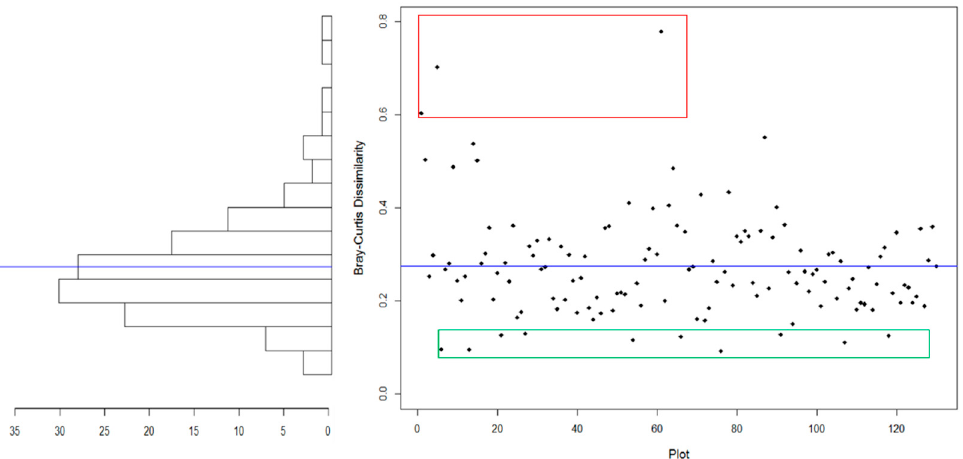
Figure 5. Change in dissimilarity at the 0.1 ha subplot level between 1998–2012 across Mts. Jiri and Baegun. The blue line indicates the mean dissimilarity value. The red box represents the high dissimilarity subplots, while the green box represents the low dissimilarity subplots.